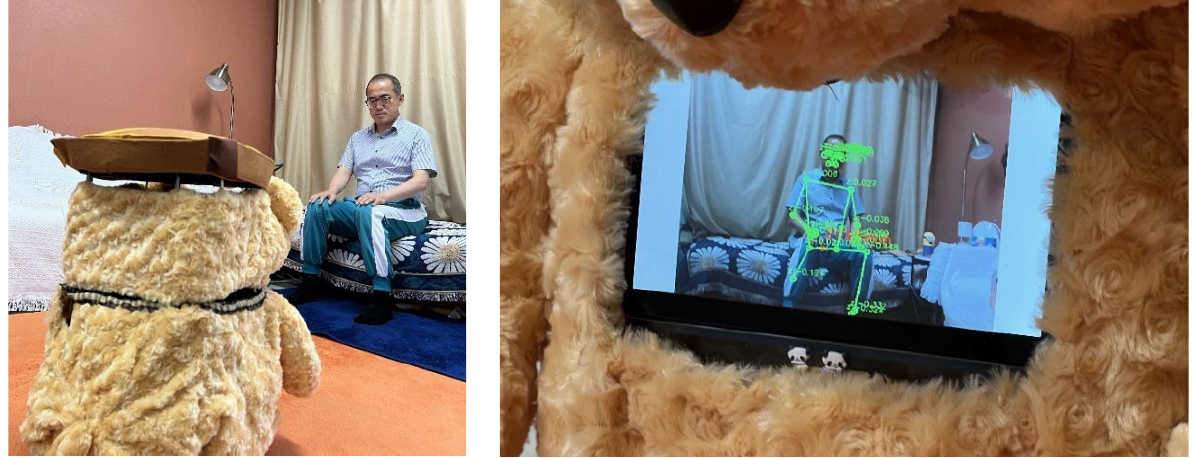
Figure 10. Left: Dori and the user under monitoring service. Right: Skeletal model is extracted from camera image using MediaPipe Pose.